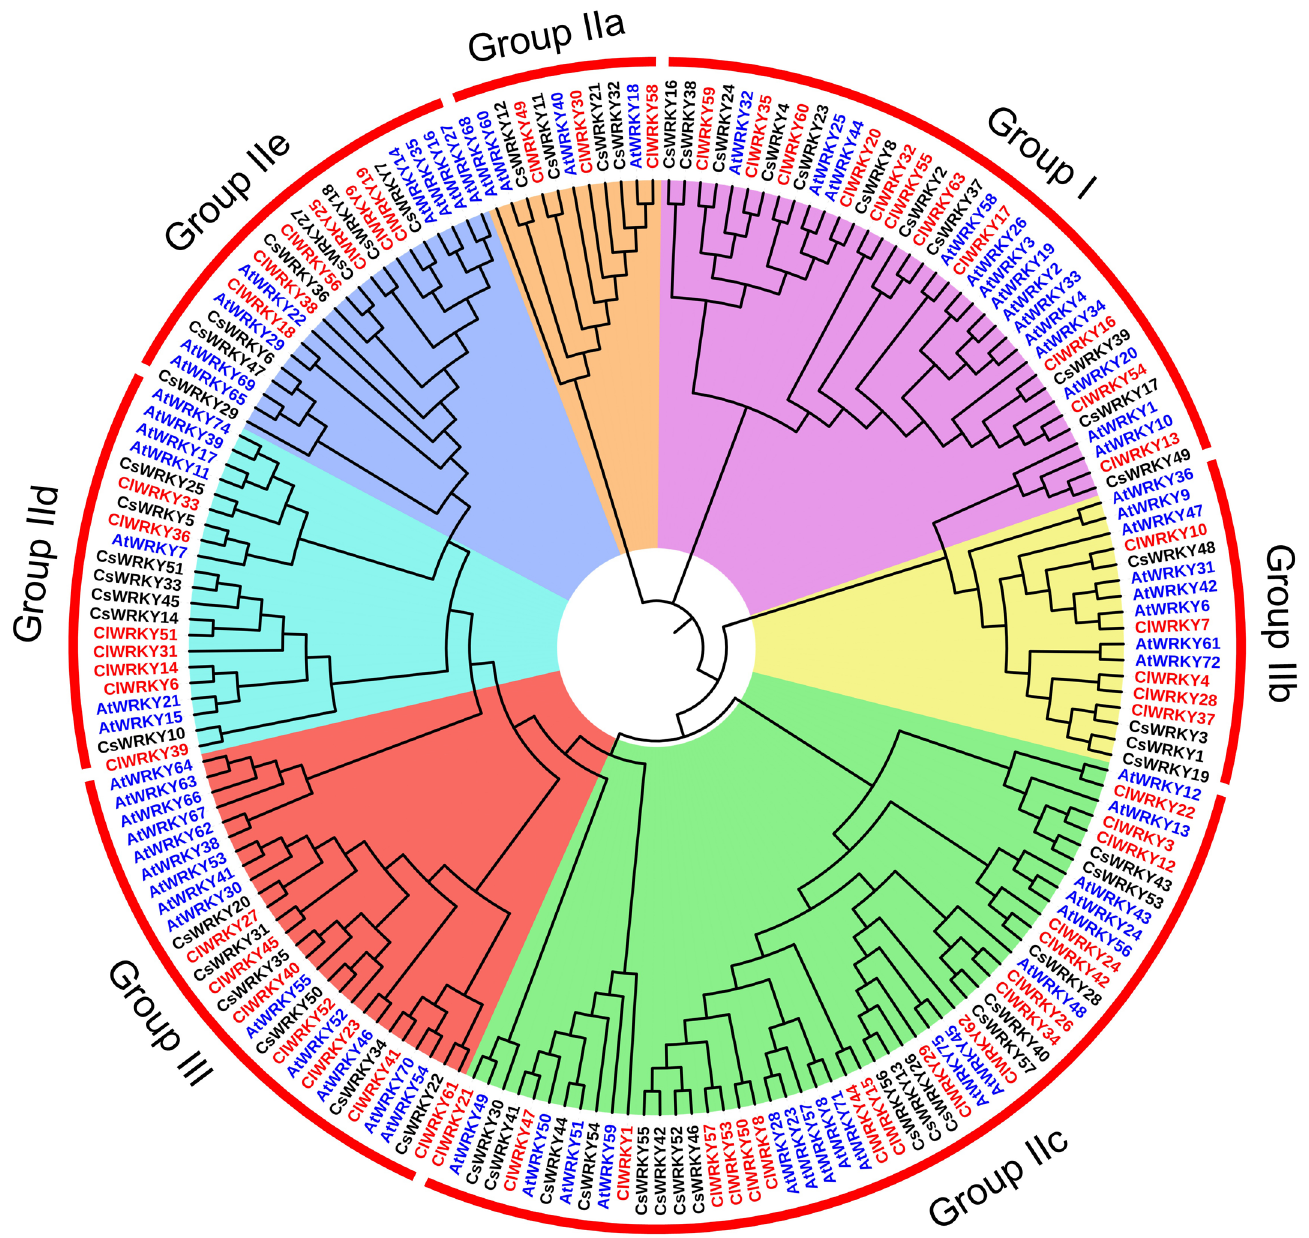
Fig 2. The phylogenetic tree of 184 WRKY genes among watermelon (red), Arabidopsis (blue) and cucumber (black). The domains clustered into three major groups I, II, III, and five subgroups (a, b, c, d, and e) in group II.